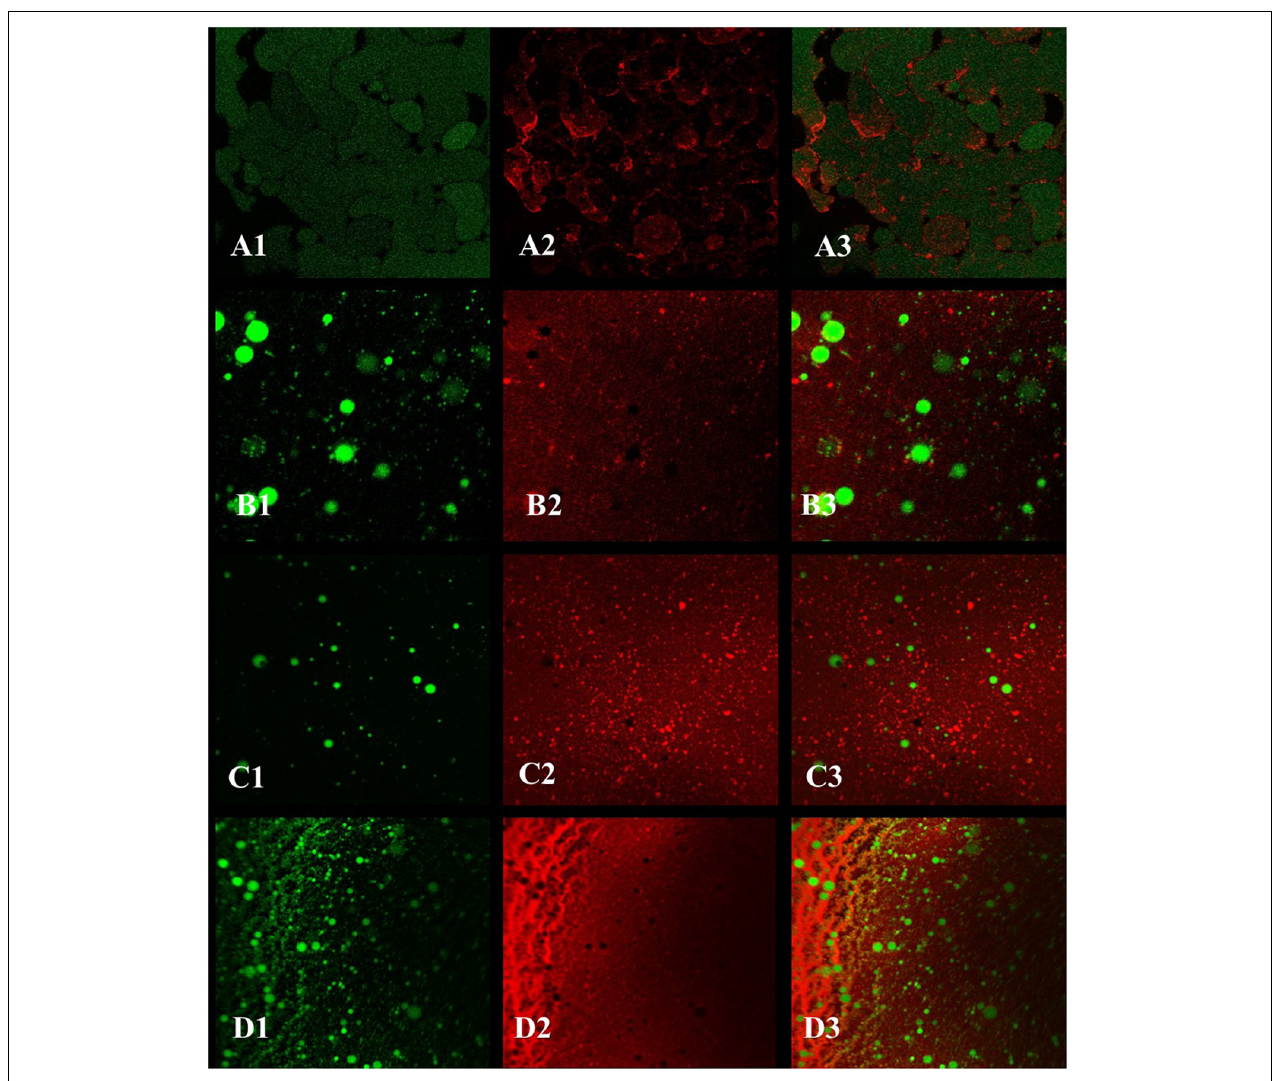
FIGURE 10 | The confocal laser scanning microscopy (CLSM) images of Pickering emulsions [ (A1–A3) emulsion stabilized by ZCPs; (B1–B3) emulsion stabilized by ZLCPs; (C1–C3) emulsion stabilized by ZKCPs; (D1–D3) emulsion stabilized by